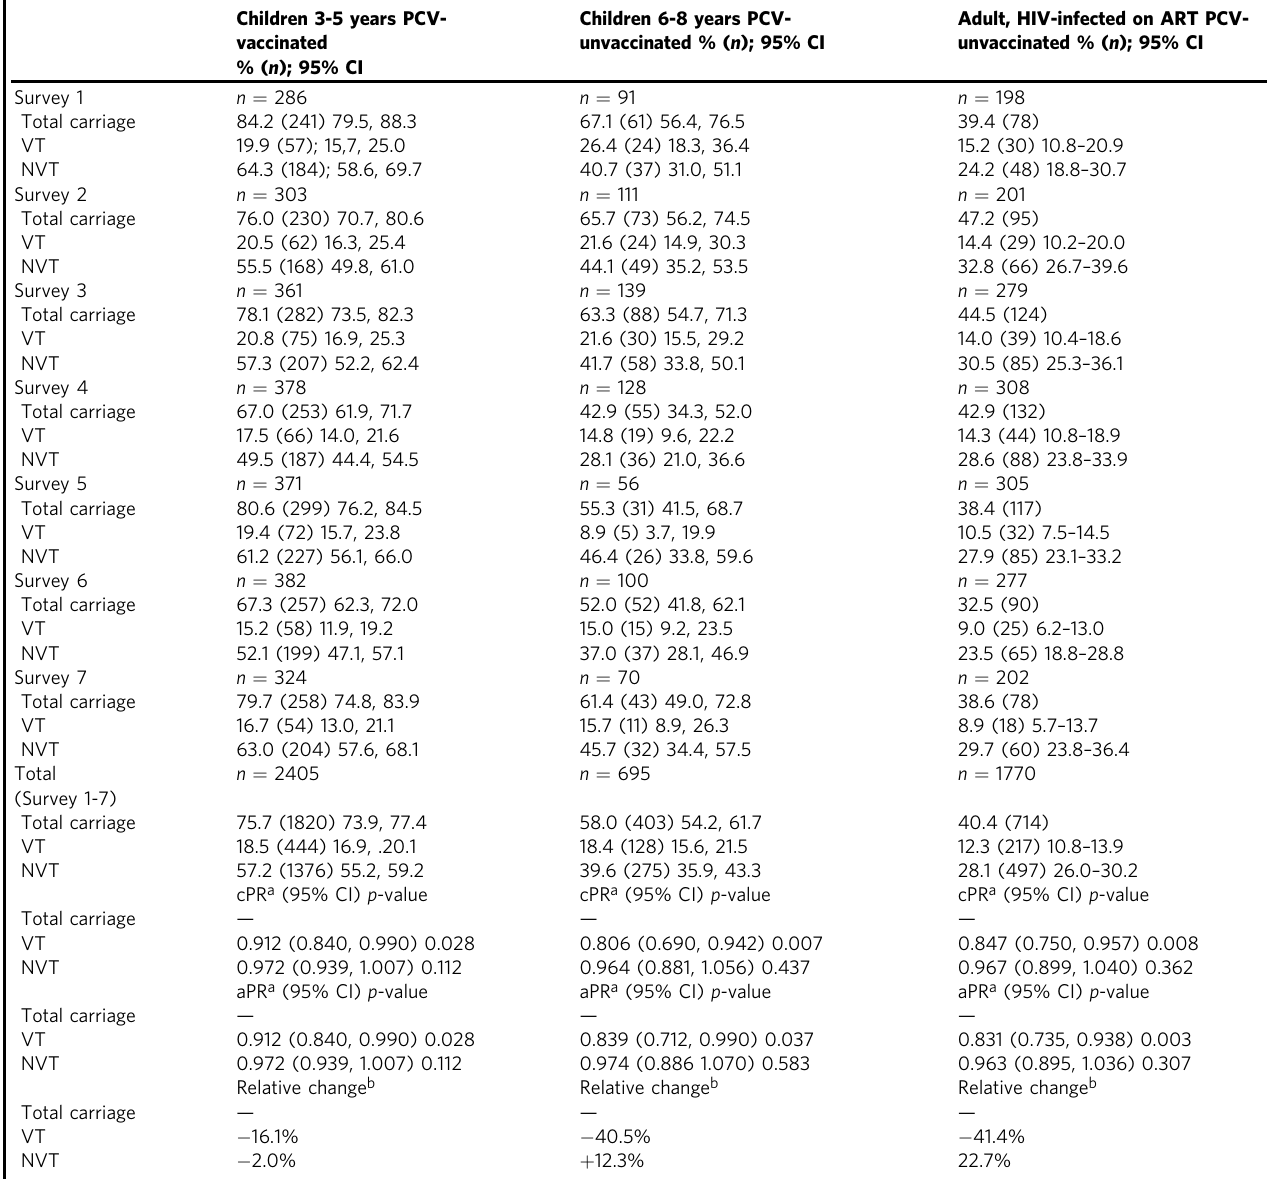
Table 2 Carriage prevalence among children and adults. Children 3-5 years PCV-